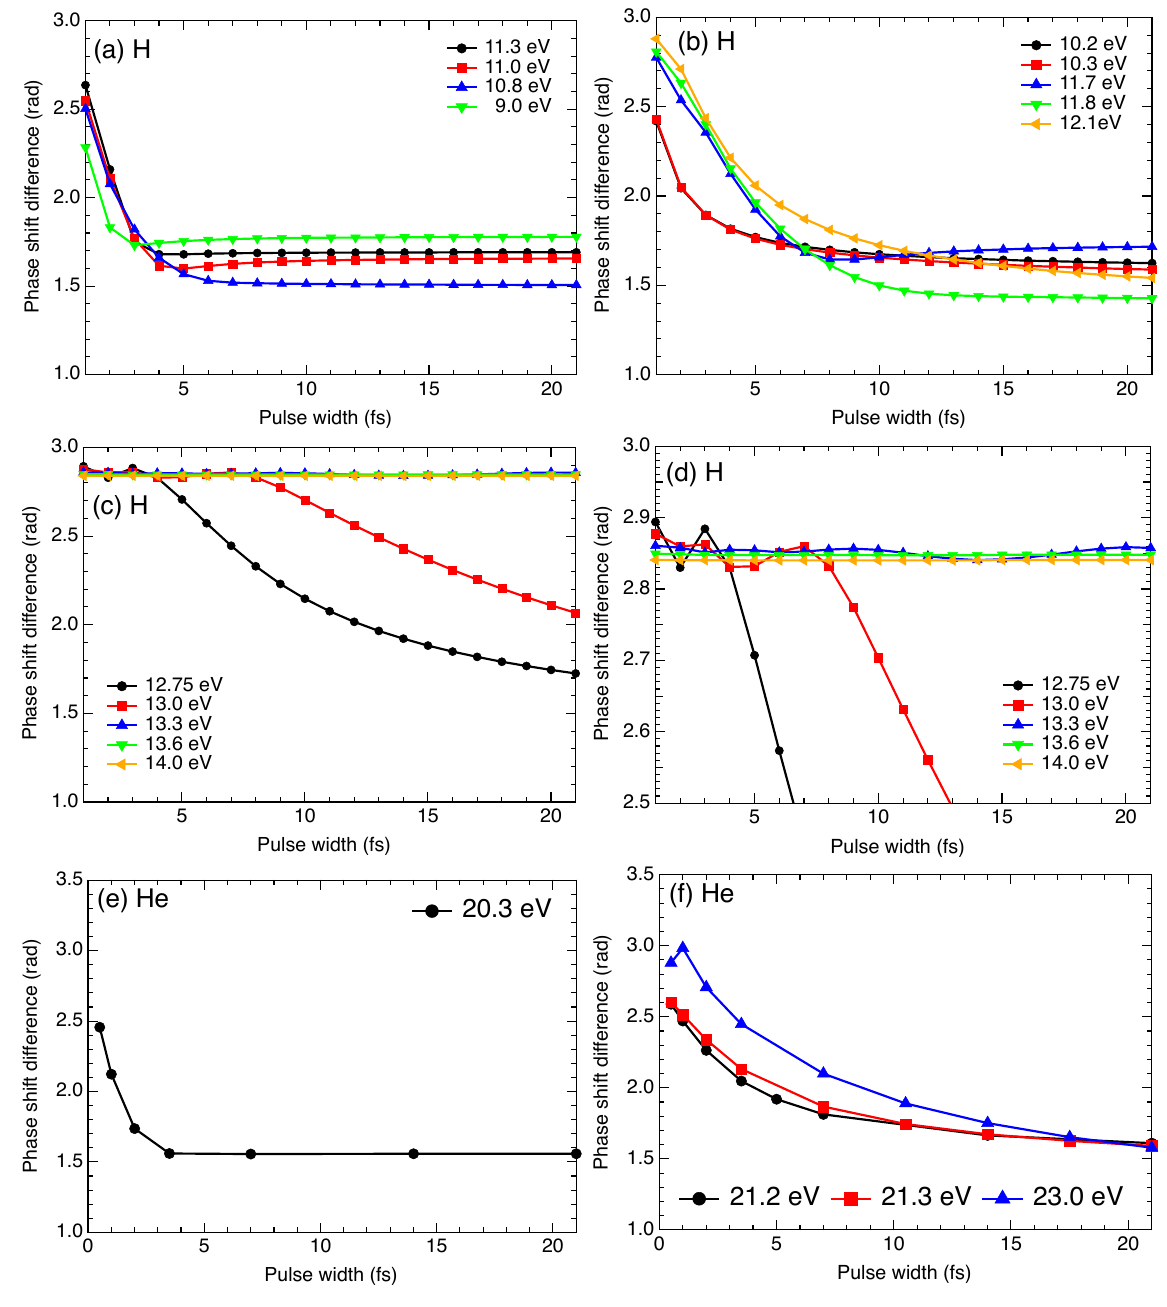
Figure 4. Pulse-width dependence of the phase-shift difference δ for H [( a )–( d )] and He [( d )–( g )] for different values of photon energy. Panel ( d ) is the close-up of the vertical-axis range between 2.5 and 3.0 radians of panel ( c ). The pulse is nonresonant for ( a ) and ( e ), resonant with a single level for ( b ) and ( f ), and resonant with multiple levels for ( c ), ( d ), and ( g ). The resonant excitation energies for He 1 s 2 p 1 P , 1 s 3 p 1 P , 1 s 4 p 1 P , 1 s 5 p 1 P levels are 21.218, 23.087, 23.742, and 24.046 eV